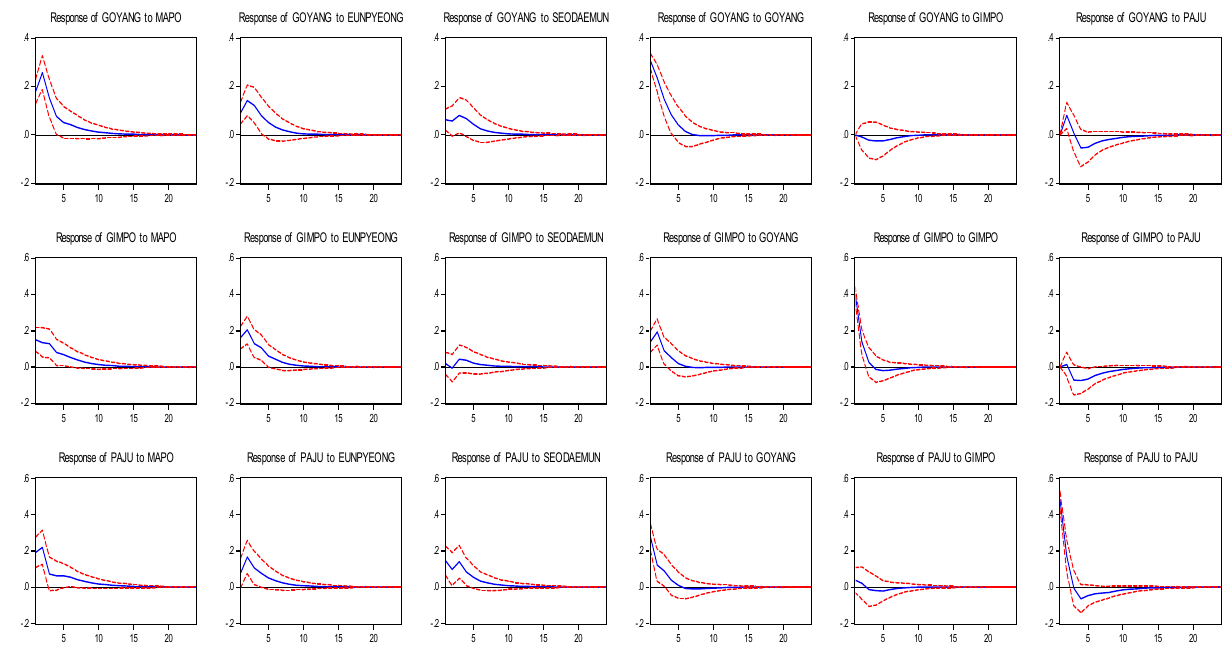
Figure 4. Impulse response analysis of the jeonse market in the Gyeongeui region. On examining the results of the variance decomposition analysis, which can confirm the contribution of other cities to the change in jeonse price, we found that in the Northwest region, the price changes in individual cities contributed the most to their own price changes. In particular, Mapo in the Northwest region had the highest influence (over 80%) on its own jeonse prices and greatly influenced the jeonse price changes in other cities in the Northwest region. Furthermore, in other cities, their own price changes were found to be an important factor regarding the changes in their own jeonse markets, but the effect was found to be lower than that of Mapo. These results reveal that the highest-priced city (primary city) drove the spillover, causing price changes in other cities (See Figure 5).